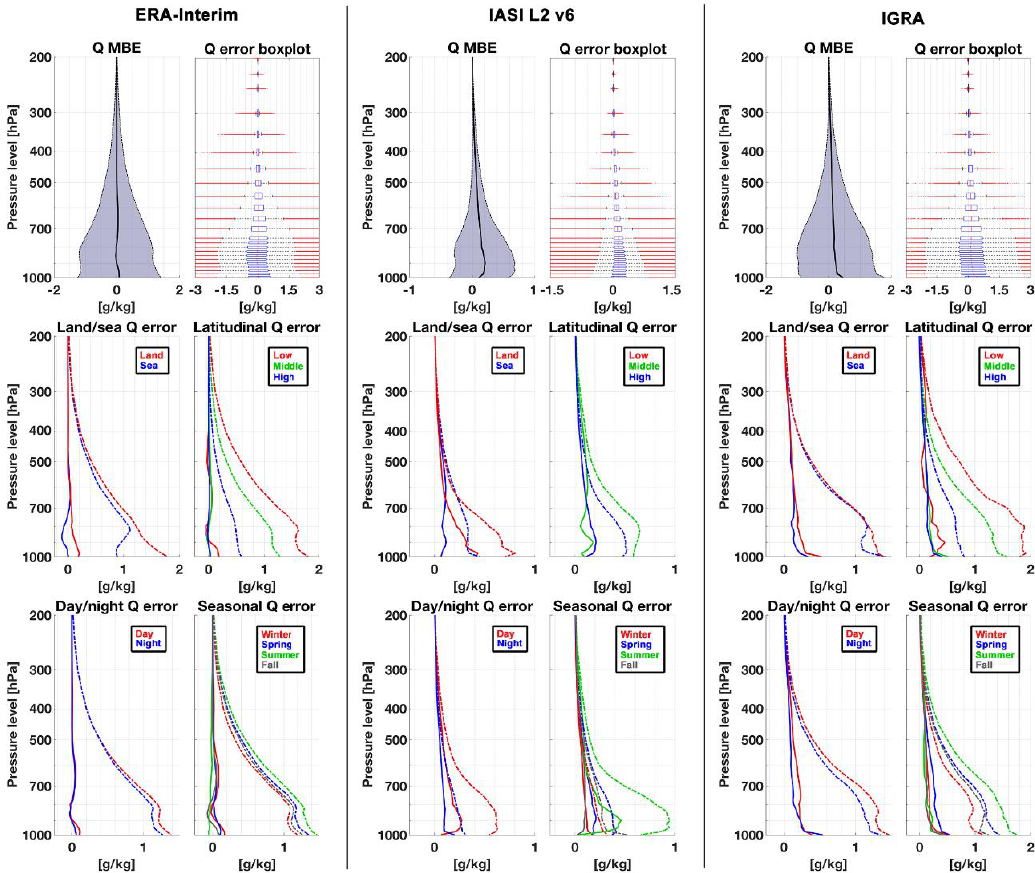
Figure 10. Top panels: Q MBE with the standard deviations and errors boxplot for ERA-Interim ( left ), IASI L2 v6 ( center ), and IGRA ( right ) separately. Middle and bottom panels show MBE (solid lines) and RMSE (dashed lines) for land/sea surface, high/middle/low latitude, day/night, and the four seasons. The 2017 validation dataset is used to compute the statistics.